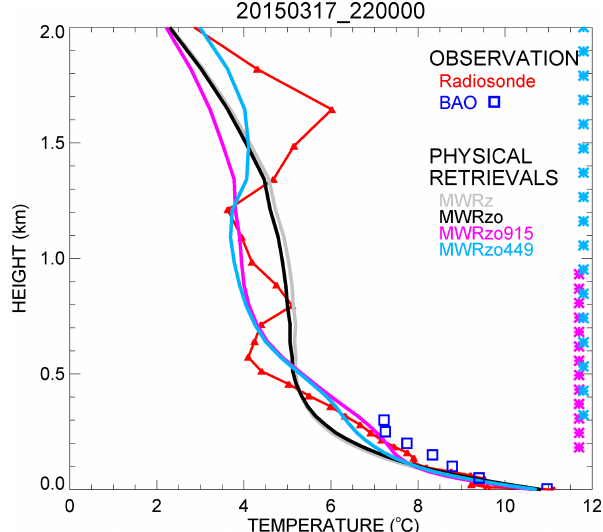
Figure 2. Temperature profiles obtained by the four PR configura- tions, after applying the radiosonde BC to the MWR T b s: MWRz in gray, MWRzo in black, MWRzo915 in magenta, and MWRzo449 in light blue. These retrievals are compared to radiosonde mea- surements, in red, and BAO tower observations, as blue squares. The heights with available RASS virtual temperature measurements (RASS 915 in magenta and RASS 449 in light blue) are marked by the asterisks on the right y